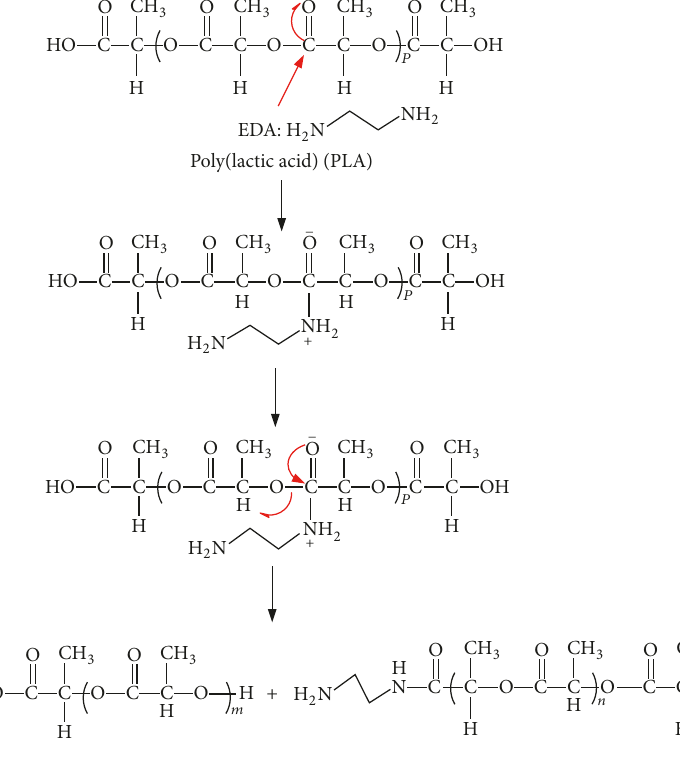
Figure 1: Aminolysis mechanism of PLA with